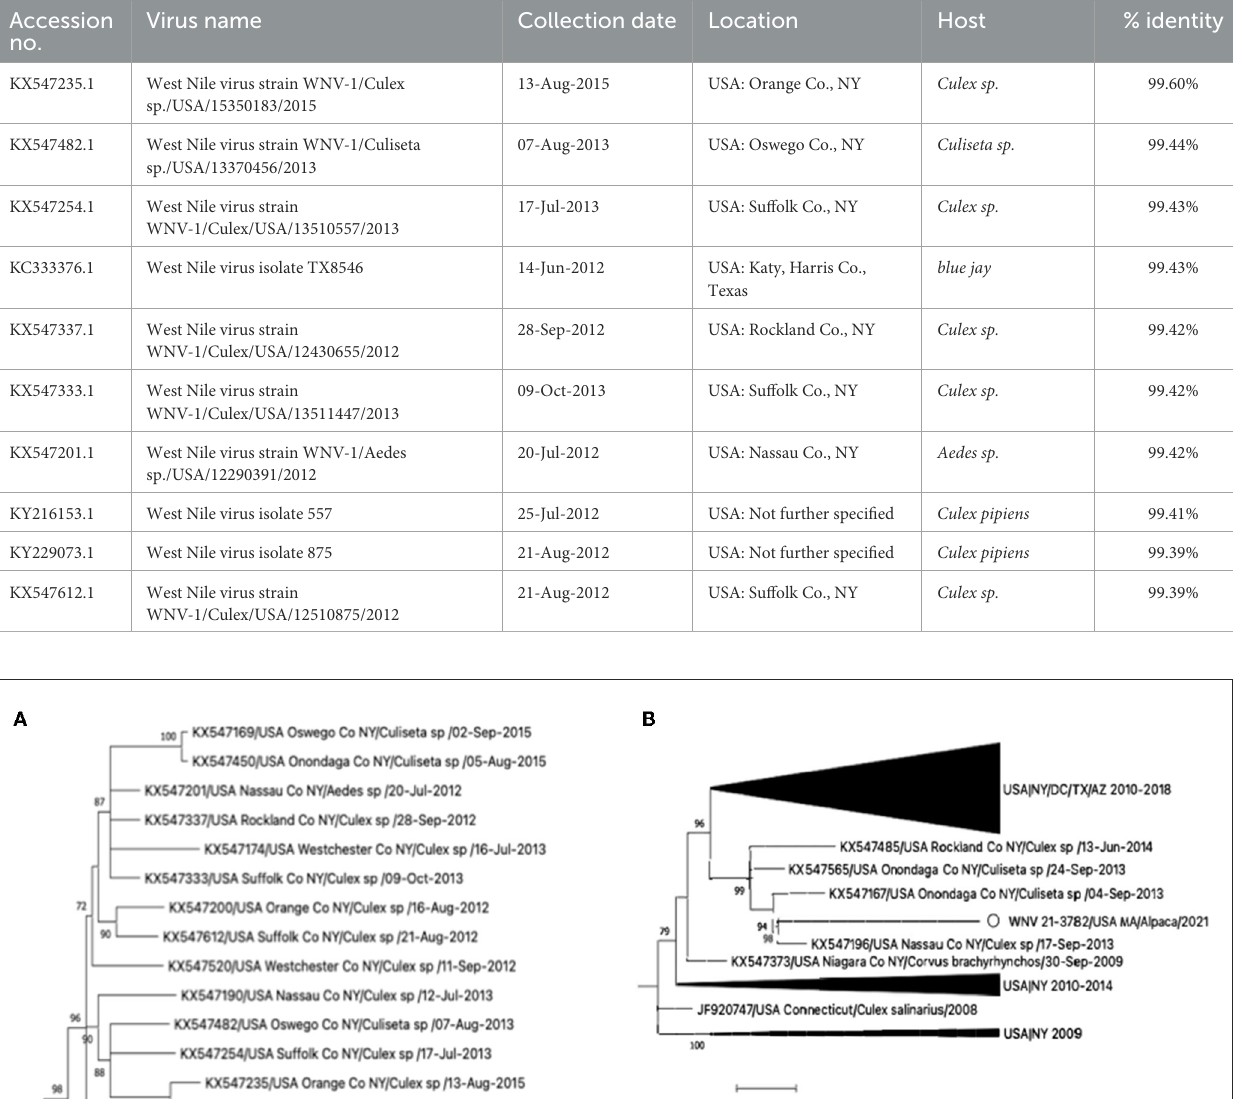
TABLE 2 Nucleotide sequence identities between the WNV 21-3957/USA CT/Crow/2021 virus and nearest virus homologs in the GenBank database (as of 15 May 2022). Accession no.